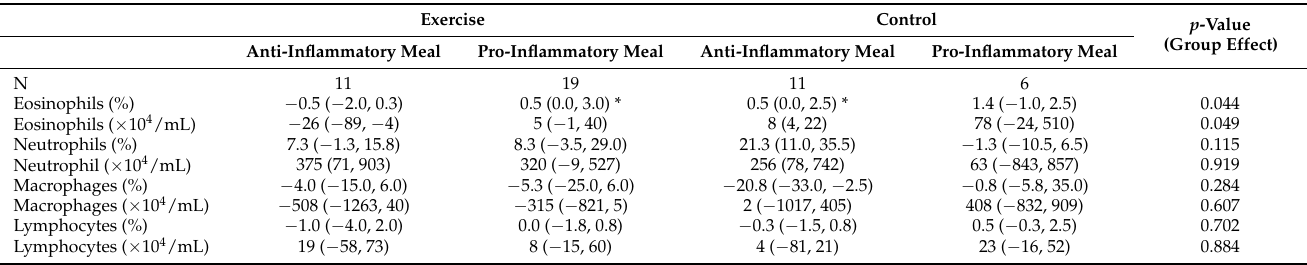
Figure 2. Change in sputum %eosinophils, according to intervention and inflammatory potential of the meal consumed two hours post-intervention. AI: anti-inflammatory; PI: pro-inflammatory. Table 2. Change in airway inflammation, according to intervention and inflammatory potential of the meal consumed two hours post ‐ exercise.